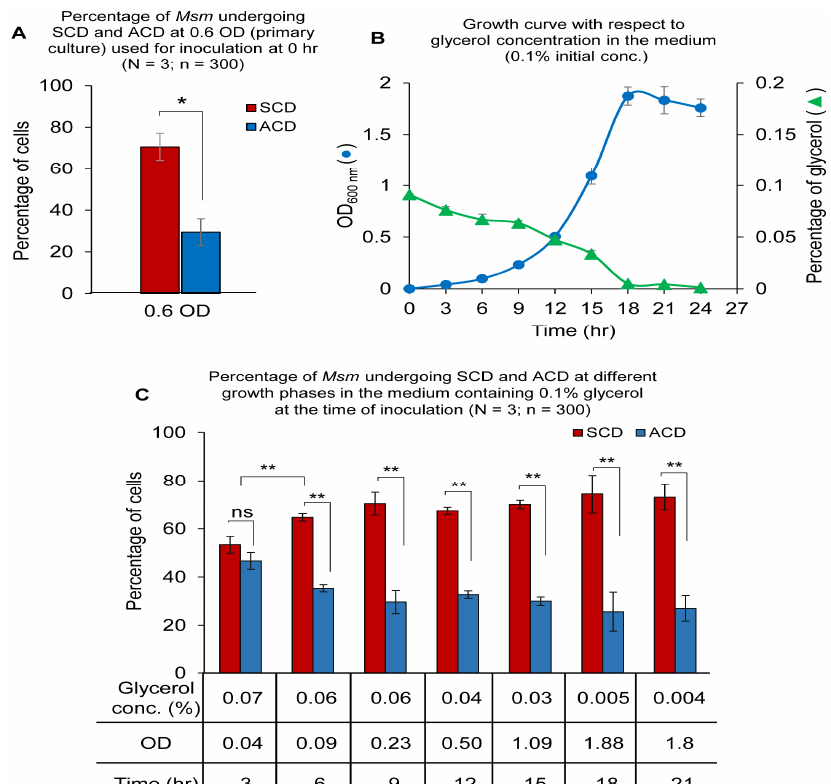
Figure 4. Growth curve of Msm cells, glycerol concentration in the medium, and proportion of the cells undergoing ACD/SCD in Middlebrook 7H9 liquid medium containing 0.1% glycerol and 0.05% Tween 80. ( A ) Percentage of the cells dividing by ACD/SCD at 0.6 OD of primary culture raised from glycerol stock and used for inoculation at 0 hr. ( B ) ( ● ) Growth curve of Msm with respect to ( ) glycerol concentration. ( C ) Percentage of the cells dividing by ACD/SCD at different glycerol concentrations and OD values at 3 h time intervals, n = 300. The data shown are for biological triplicates and represented with mean values ± s.d. ns—no significance, p < 0.05 *, p < 0.01 **, via two-tailed t -test.